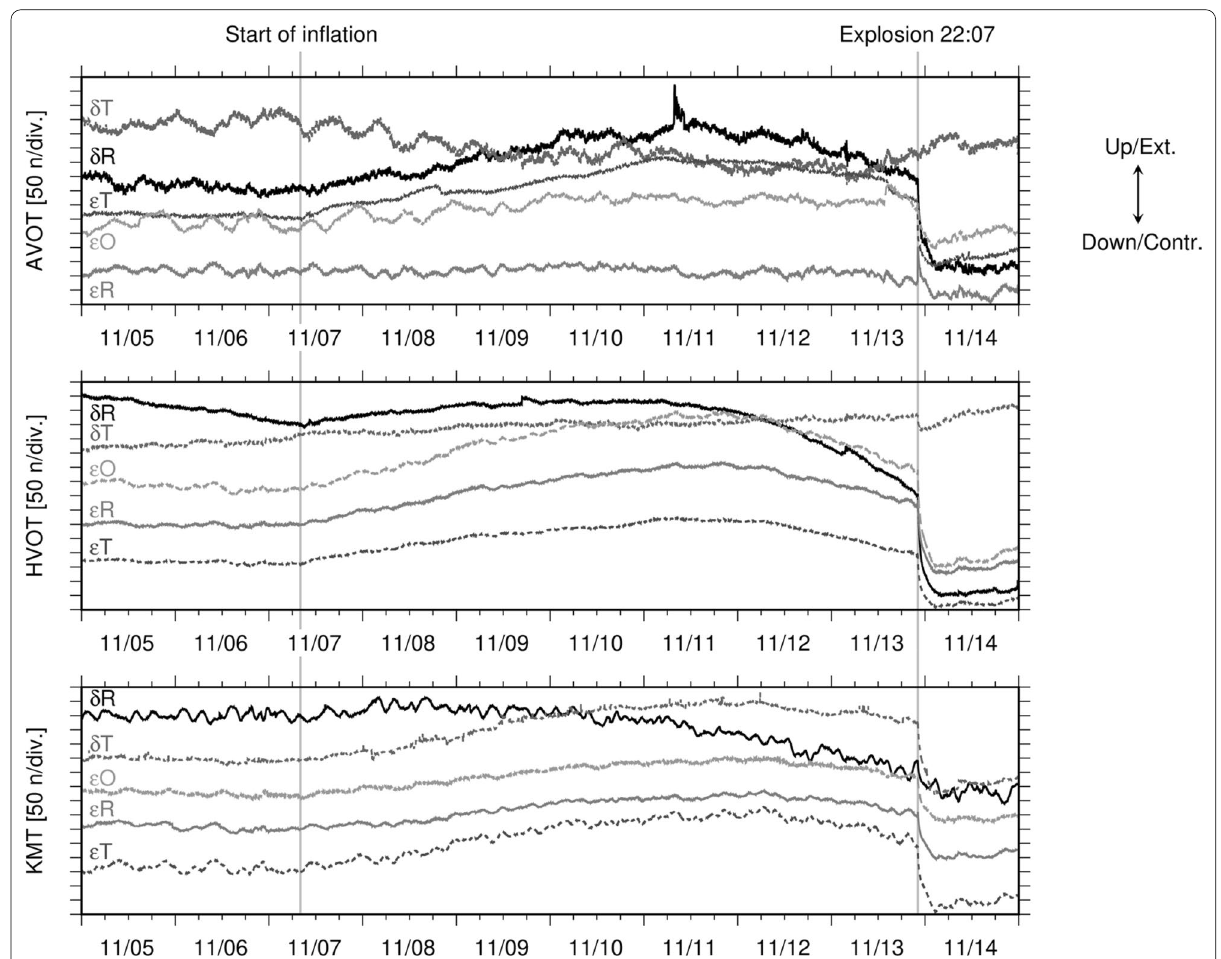
Fig. 2 Tilt and strain records at the AVOT, HVOT and KMT stations during the period from November 5 through 14, 2017. δR and δT represent radial and tangential tilt changes, respectively. εR, εT and εO are strain changes in the radial, tangential and oblique components, respectively. The increase in the tilt represents an upward change in a direction toward the Minami-dake crater in the radial component and in a direction rotated clockwise 90° from the crater in the tangential component. The increase in the strain represents an extension of the radial component in a direction toward the crater and a direction rotated clockwise 90° and 45° from the crater in the tangential and oblique components, respectively. The two vertical gray lines represent the start of inflation on November 7, 2017 and the onset of the explosion at Minami-dake on November 13, 2017,